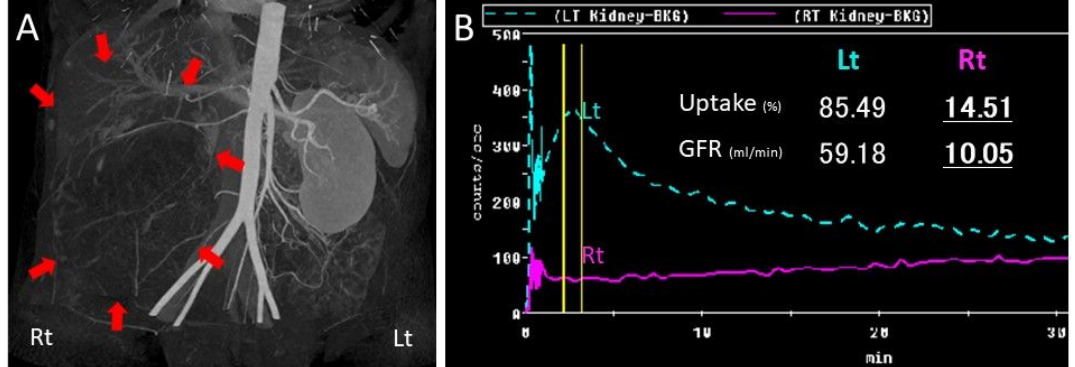
Figure 2. Three-dimensional computed tomography showed that the cortex of the right kidney indicated by the red arrow was slightly enhanced ( A ). Tc99m dimercaptosuccinic acid renal scan revealed the uptake and glomerular filtration rate (GFR) was 85.49% and 59.18 mL/min from the left kidney and 14.51% and 10.05 mL/min from the right kidney, respectively ( B ).